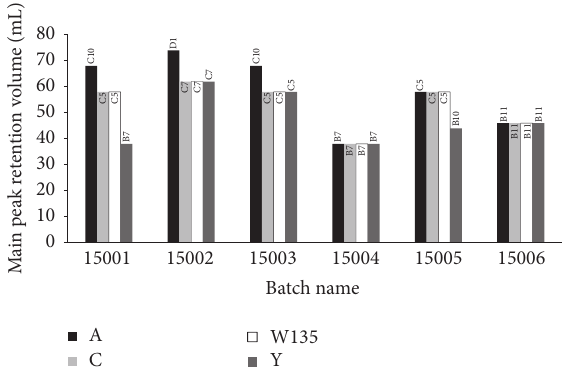
Figure 4: Principal peak fraction volume of six batches of Ingovax ACWY